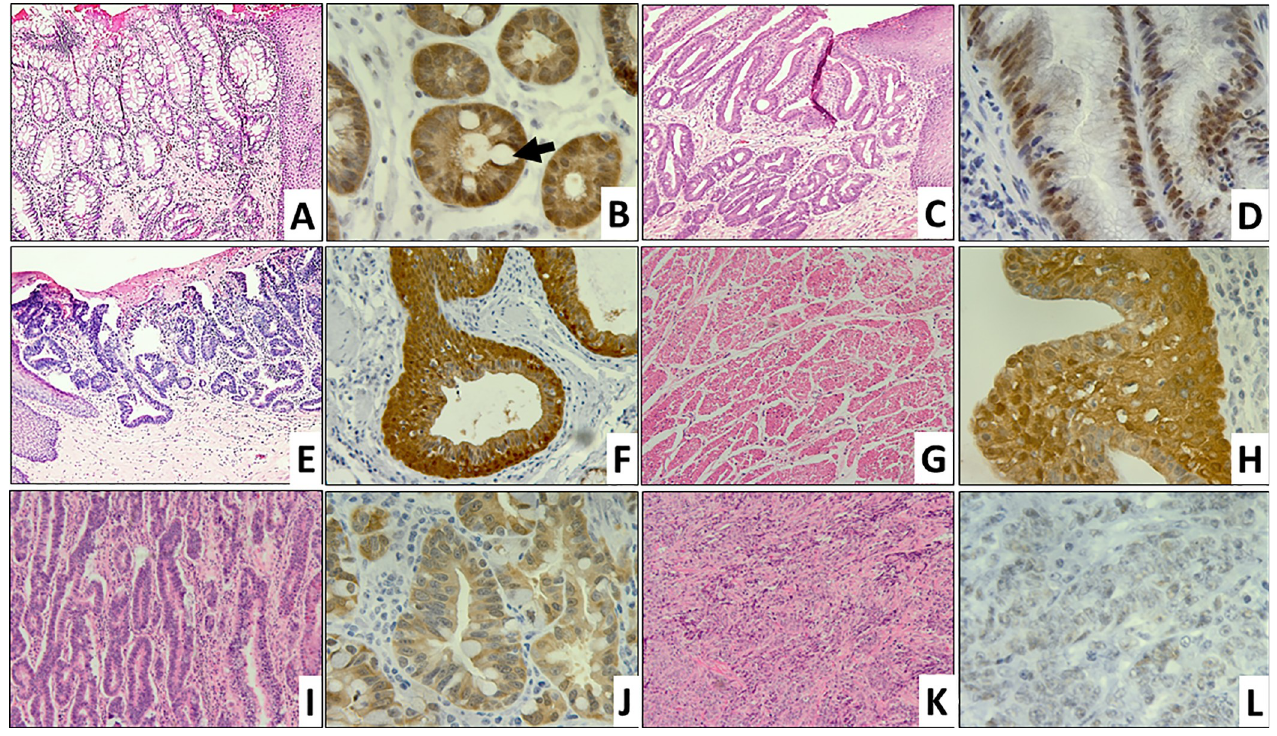
Fig 2. Differential expression of maspin in ECA/GEJ Aca progression. Representative microscopic images of GEJ lesions. H&E (A, C, E, G, I, and K, 100x) and maspin IHC (B, D, F, H, J and L, 400x) staining, respectively, of: A. and B. IM showing Goblet cells ( ! ); C. and D. LGD; E. and F. HGD; G. and H. WD-ECA/GEJ Aca; I. and J. MD-ECA/GEJ Aca; and K. and L. PD-ECA/GEJ Aca.